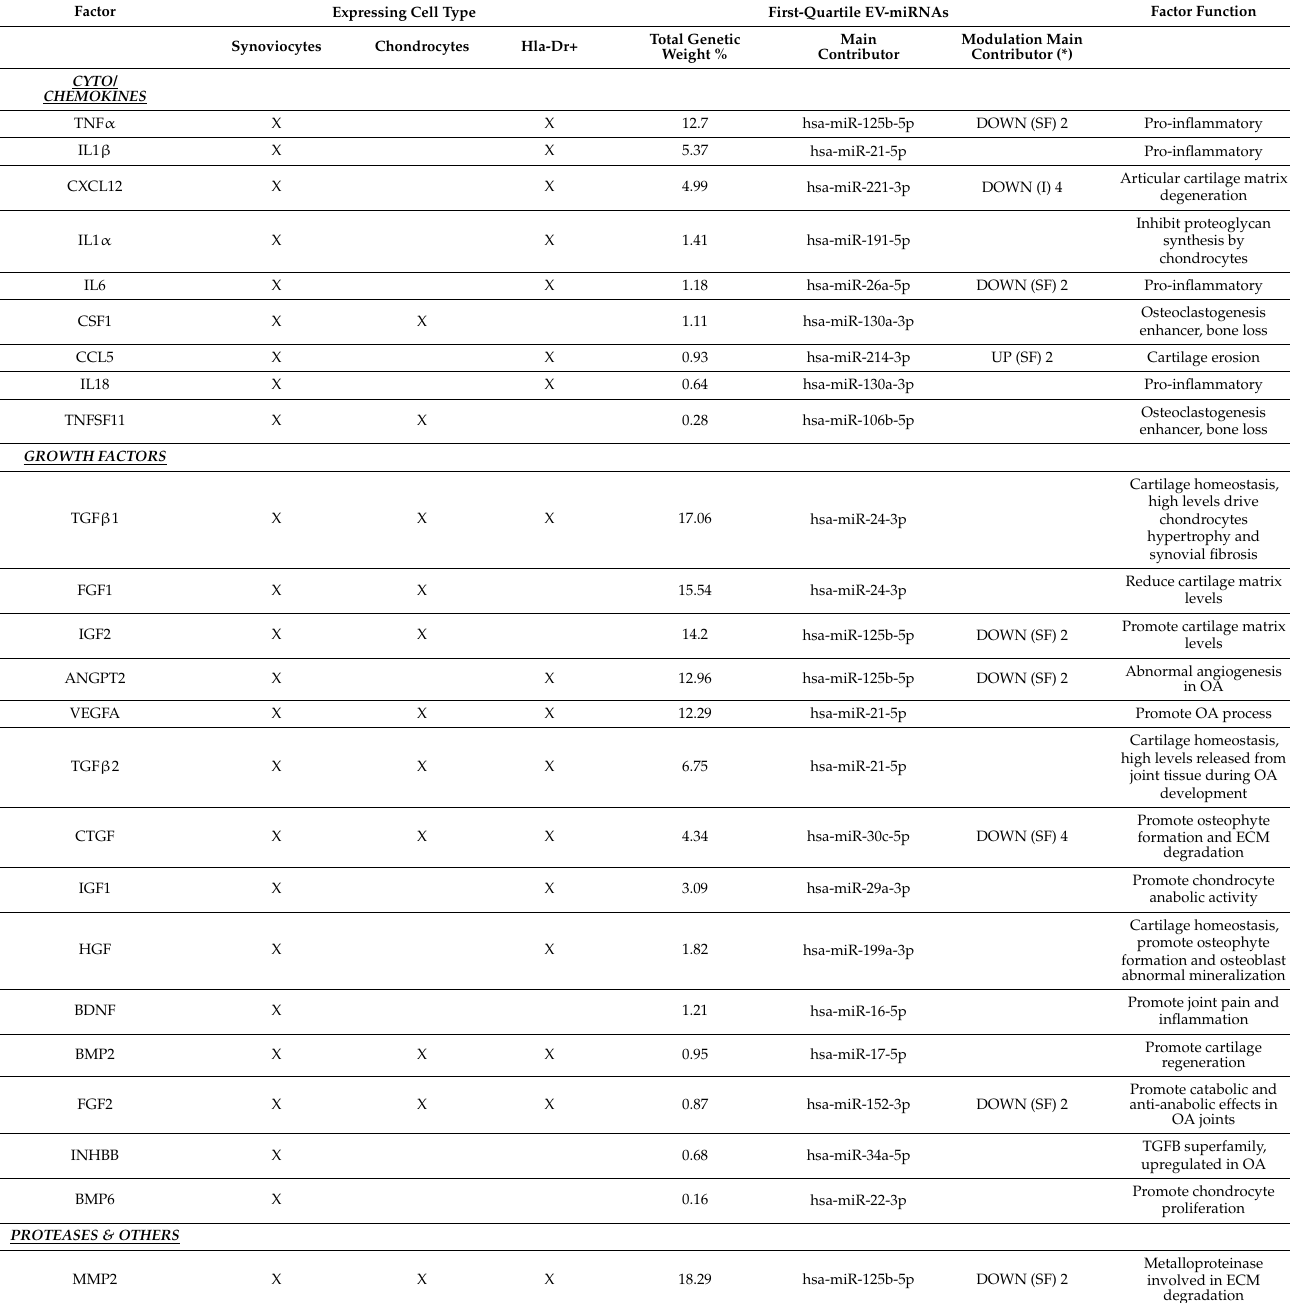
Table 2. Soluble factors involved in the OA pathological state and the genetic weight of targeting the first-quartile EV-miRNAs. Cell type release for each factor is indicated with